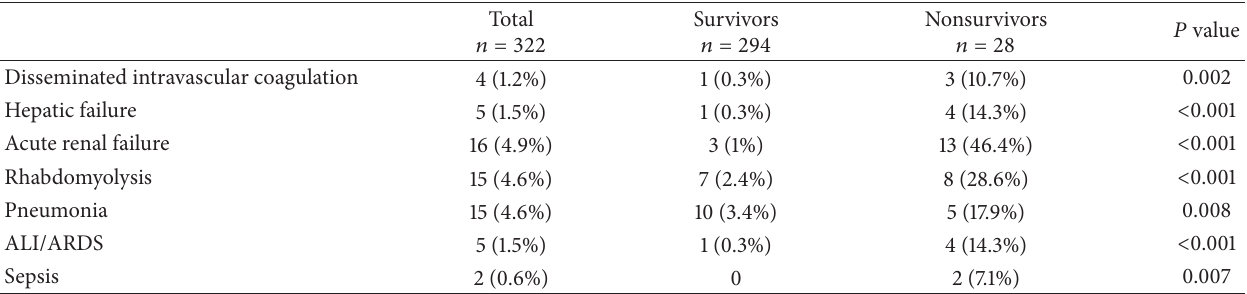
Table 4: The relative frequency of